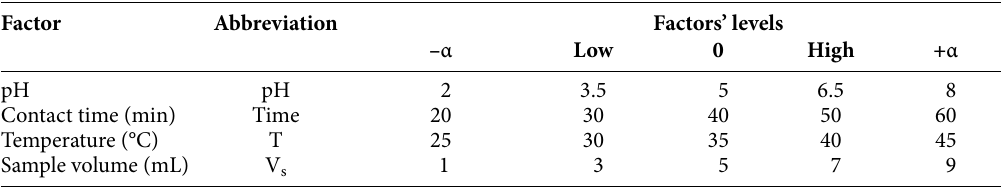
Table 1. The studied parameters and suggested levels in the CCD optimization.